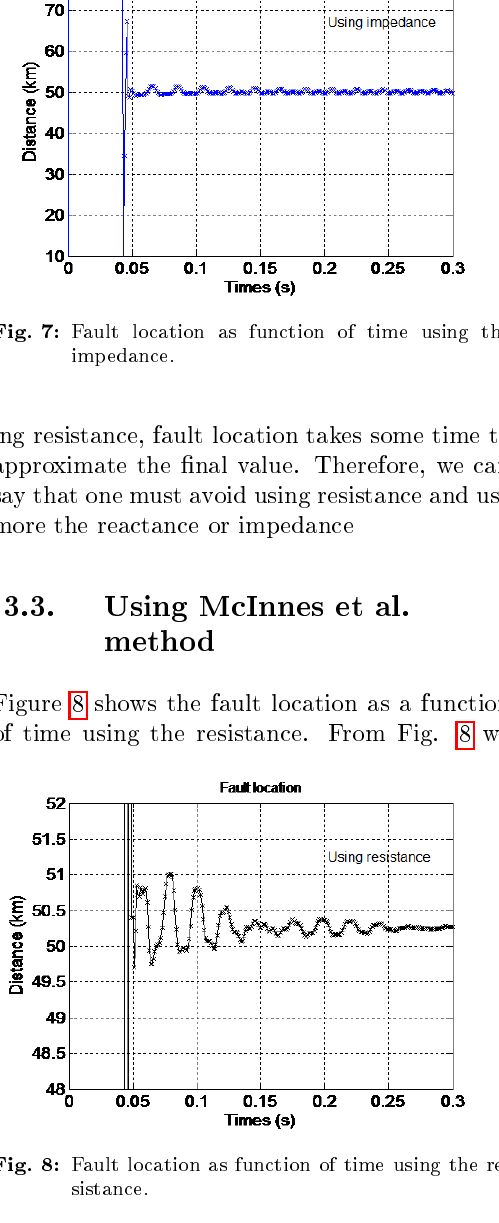
Fig. 9: Fault location as function of time using the re- actance.